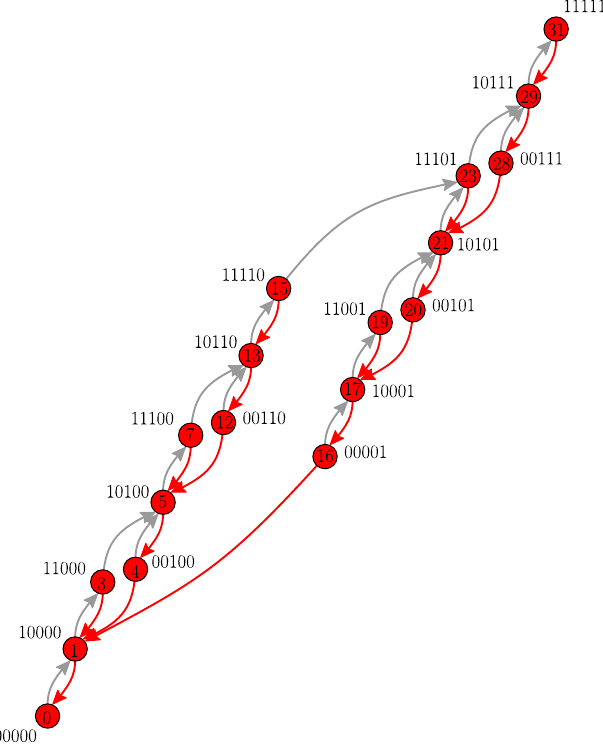
FIG. 5. TIL transition graph with L ¼ 5 and nested hysteresis loops. This graph was generated from a system with trade-off among all pairs of mutations, i.e., requiring that r i <r j ⇔ m i >m j for all i , j , and considering only transitions under greedy adaptive walks. The nesting of graph loops implies that genotypes can partially encode past changes of concentration. For example, starting from the wild type 0 at concentration x ¼ 0 , the genotype 19 can be realized only by increasing first the concentration enough in order to reach at least 23, followed by a decrease leading to at least 17 (but not further than 16) and a final increase of